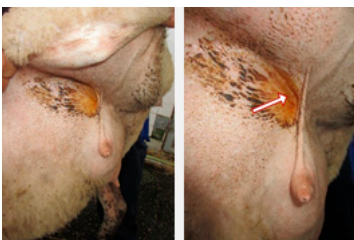
Figure 1. By abduction of the hind-left leg one can observe the skin pouch (IGS) over the mammary gland. On the right, the arrow points out the IGS and its yellowish secretion.